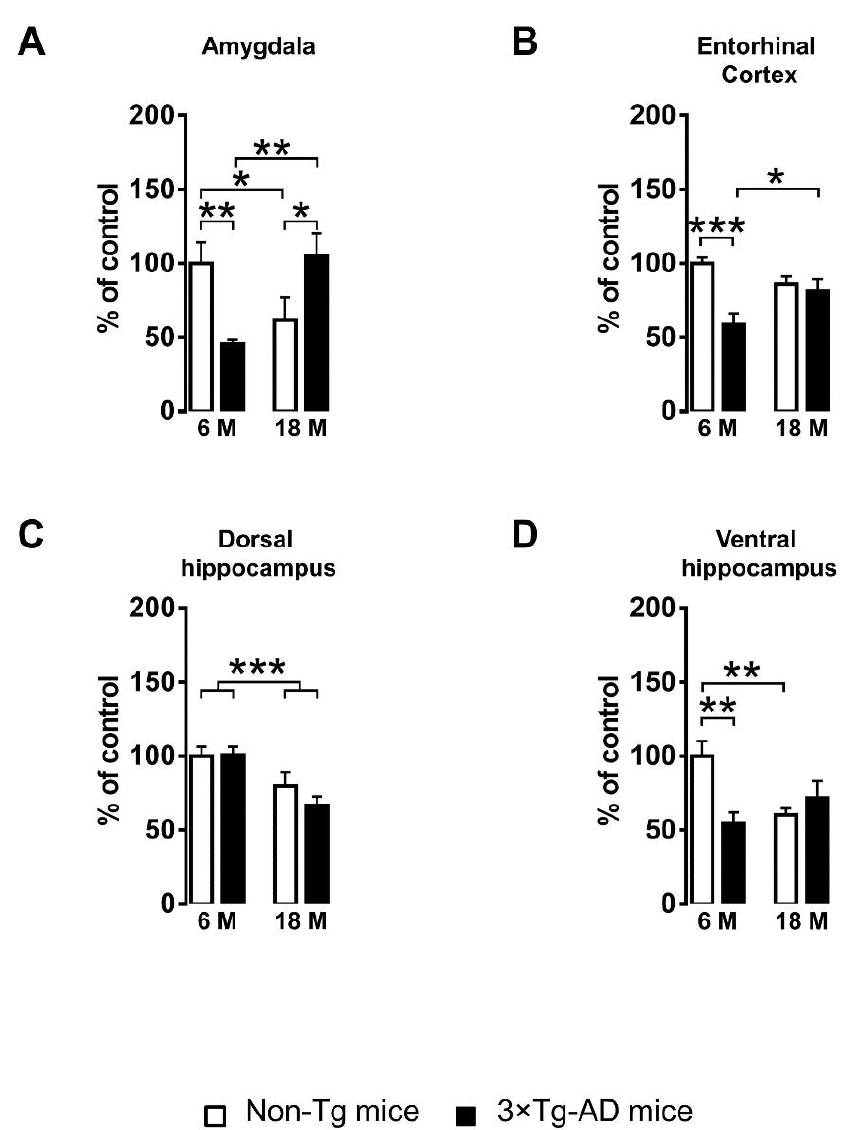
Figure 1. PDIA3 protein expression in Non-Tg and 3 × Tg-AD mice. PDIA3 protein levels were detected by dot blot assay in different brain regions of the limbic system collected from 6- and 18-month-old Non-Tg and 3 × Tg-AD mice. The limbic regions considered include: ( A ) amygdala; ( B ) entorhinal cortex; ( C ) dorsal hippocampus; ( D ) ventral hippocampus. Protein levels of all mice were normalized to those measured in 6-month-old Non-Tg mice, which were used as a control group. Data are expressed as means ± SEM. All data were analyzed by two-way ANOVA; Tukey’s test was used as a post hoc test to perform multiple comparisons (* p < 0.05; ** p < 0.01; *** p < 0.001). To investigate whether the progression of AD-like pathology may be paralleled by an altered expression of PDIA3 over time, we evaluated its levels at the mild and severe stages of the disease. Interestingly, 18-month-old 3 × Tg-AD mice showed a significant increase of PDIA3 levels in the amygdala (+130%, p < 0.01, Figure 1A) and entorhinal cortex (+38%, p < 0.05, Figure 1B), while only a trend toward an increase was observed in the ventral hippocampus (+31%, n.s., Figure 1D), as compared to 6-month-old 3 × Tg-AD mice; surprisingly, a significant decrease was observed in the dorsal hippocampus ( − 34%, p < 0.001, Figure